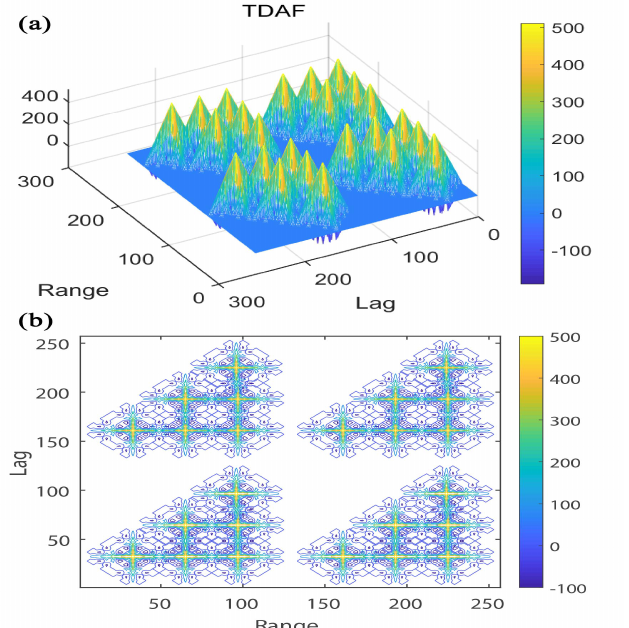
Figure 3. ( a ) TDAF of 4-bit strong alternating code modulated by 8-bit complementary code and ( b ) corresponding contour